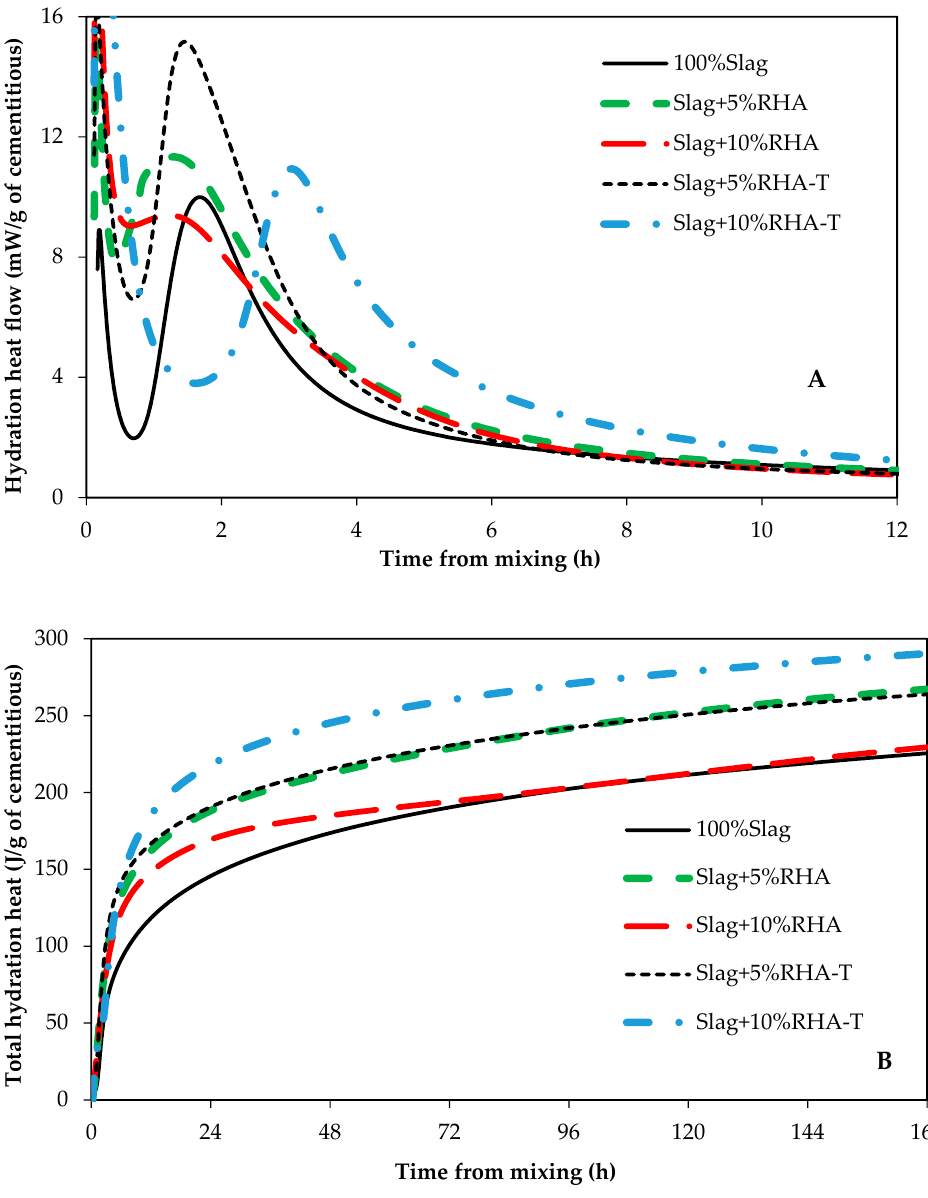
Figure 5. Hydration heat of samples containing rice hulls ash. ( A ) heat flow, and ( B ) total hydration heat.